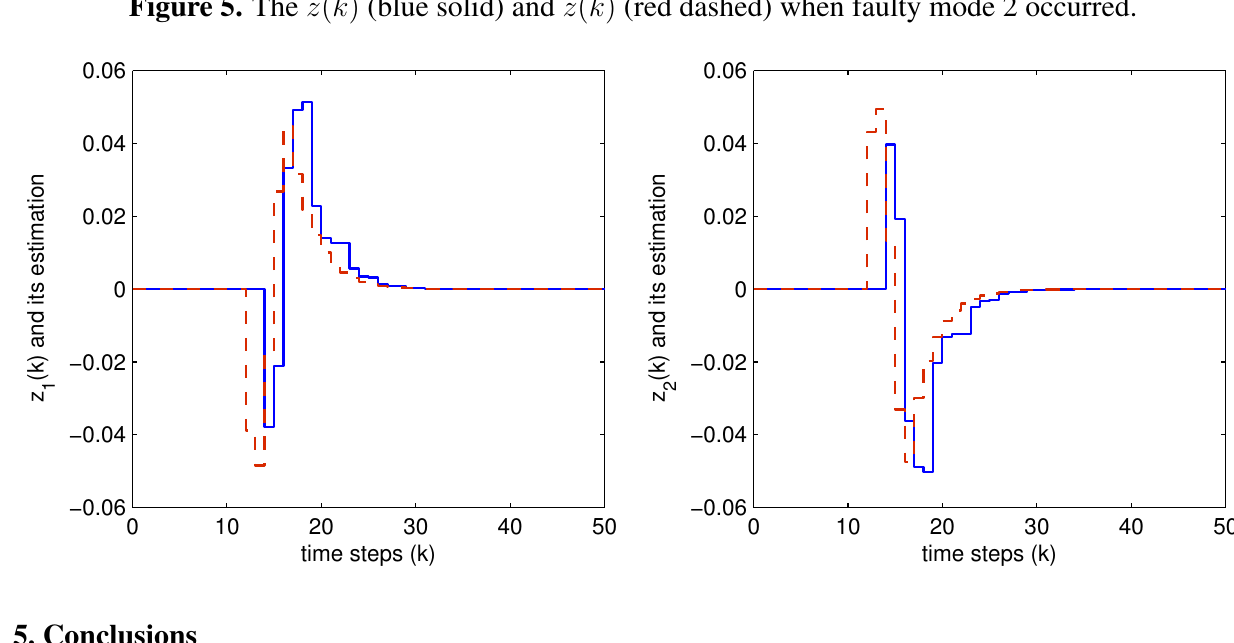
Figure 5. The z ( k ) (blue solid) and ˜ z ( k ) (red dashed) when faulty mode 2